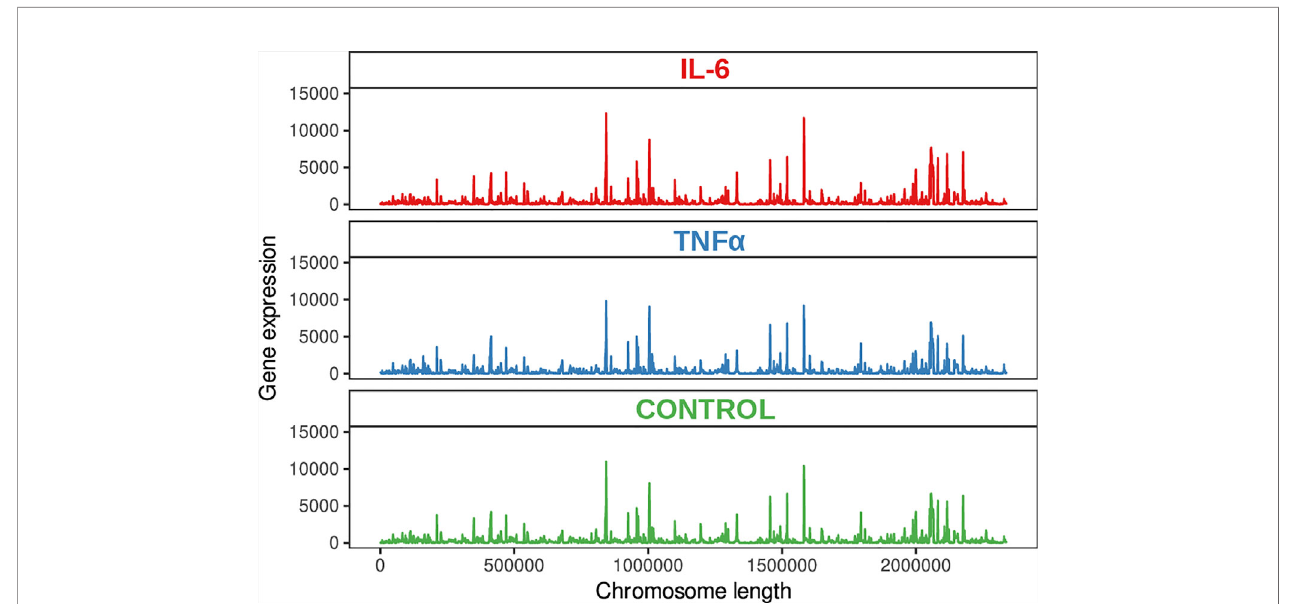
FIGURE 1 | Genome visualization shows the transcriptional map of B. longum subsp. longum